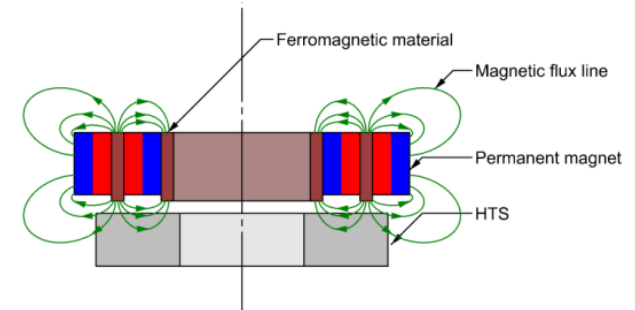
Figure 1. Rotor magnet configuration with magnetic flux convergence.